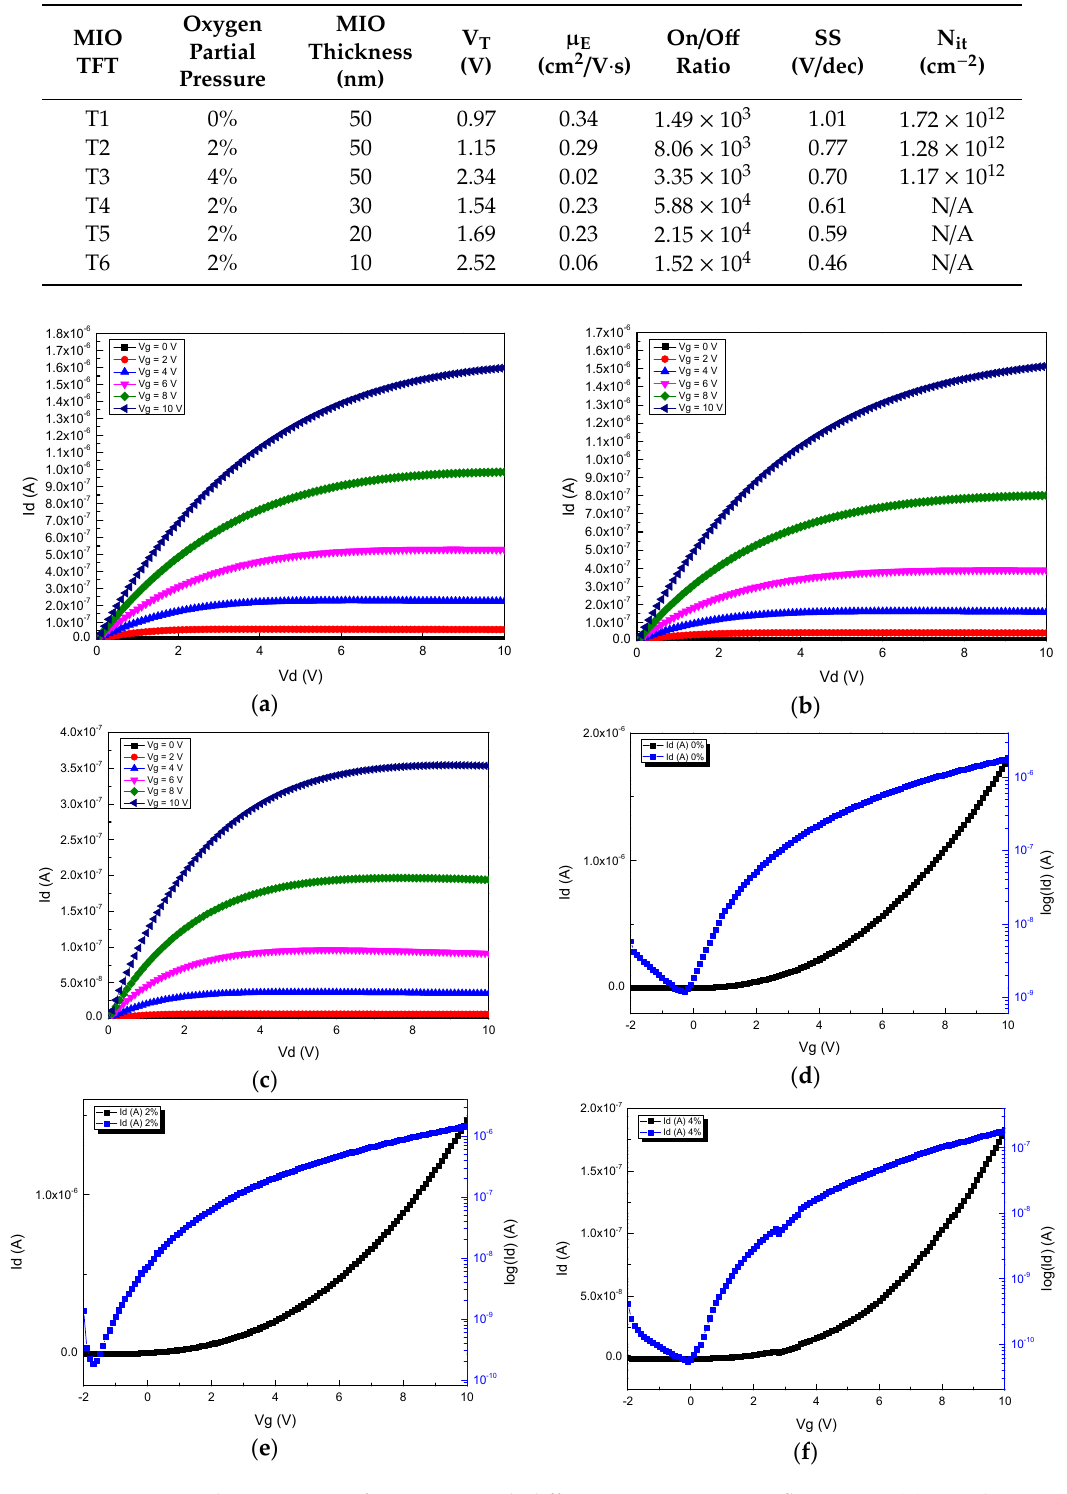
Figure 6. Output characteristics of MIO TFTs with different oxygen-to-argon flow ratios: ( a ) sample T1, ( b ) sample T2, ( c ) sample T3. Transfer characteristics of MIO TFTs with different oxygen-to-argon flow ratios: ( d ) sample T1, ( e ) sample T2, ( f ) sample T3. Table 2. Transfer characteristics of MIO TFTs with different oxygen-to-argon flow ratios or channel thicknesses.